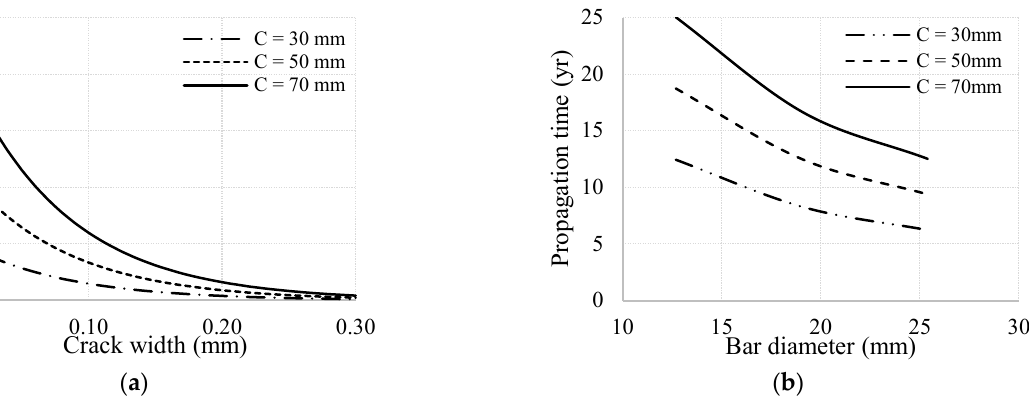
9 of 16 Figure 9. The validation of strength degradation: ( a ) Flexo ‐ compressive strength; ( b ) bending strength.